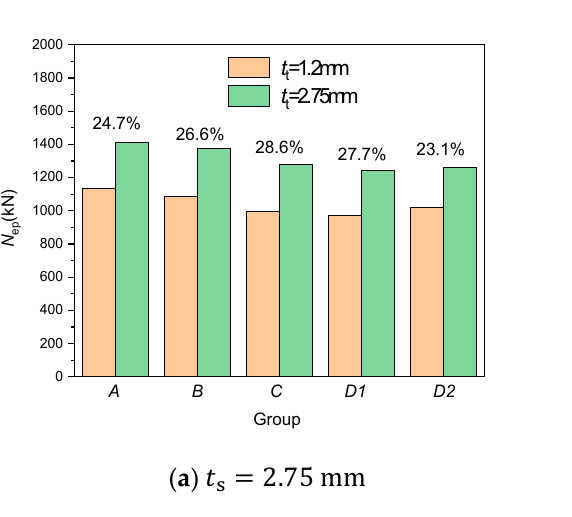
Figure 17. Effect of 𝑡 (cid:2930) on ultimate strength. As the thickness ( t (cid:2929) ) of stiffeners increases and t (cid:2930) remains unchanged, the ultimate strength of CFST columns increases. However, columns with longitudinal ribs (Type A, Type B, Type C) increased little, and columns with diagonal ribs (Type D1, Type D2) in- creased obviously. For example, f (cid:2913)(cid:2931) = 60 MPa, t (cid:2930) = 1.2 mm, the t (cid:2929) increased from 2.75 mm to 4.75 mm, and the N (cid:2915)(cid:2926) increased by 0%, 5.4%, 5.8%, 21%, and 27%, respectively, from Type A to Type D2; as the f (cid:2913)(cid:2931) = 60 MPa, t (cid:2930) = 2.75 mm, the N (cid:2915)(cid:2926) increased by 0.3%, 2.9%, 5.3%, 18.7%, and 24.3%, respectively, from Type A to Type D2, which is shown in Figure 18. So, the ultimate strength of CFST columns with diagonal ribs was greatly affected by the change in t (cid:2929) .